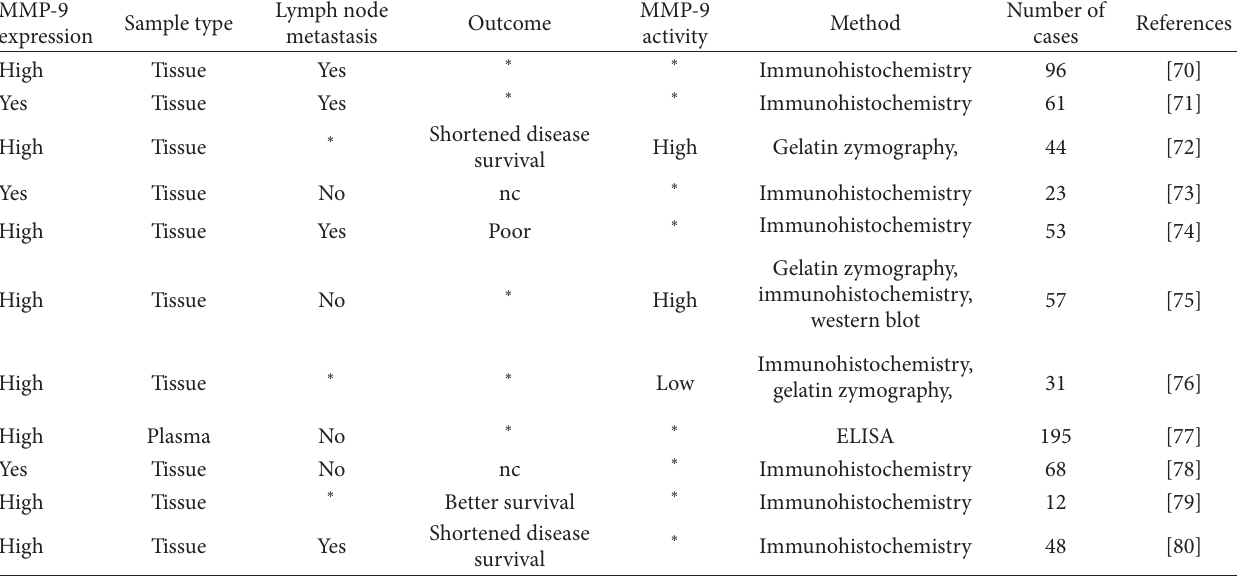
T 2: MMP-9 expression in oral